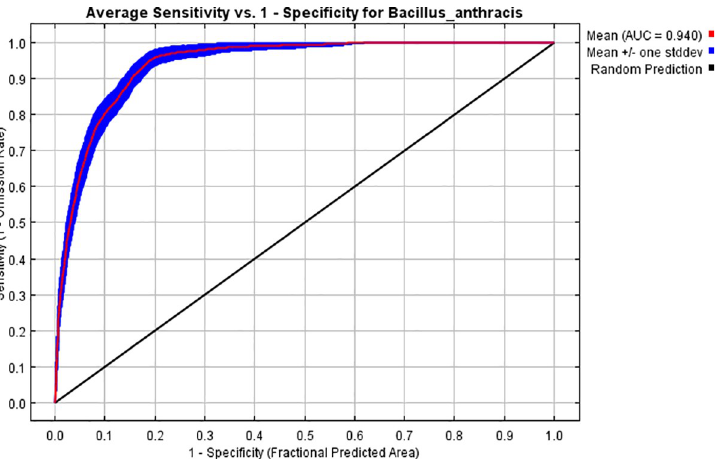
Fig 1. Mean AUC for 100 model replicate runs for predicting occurrence of B . anthracis at QEPA. AUC stands for “Area under the Receiver Operating Characteristic (ROC) Curve”. Specificity is defined using predicted area, rather than commission.